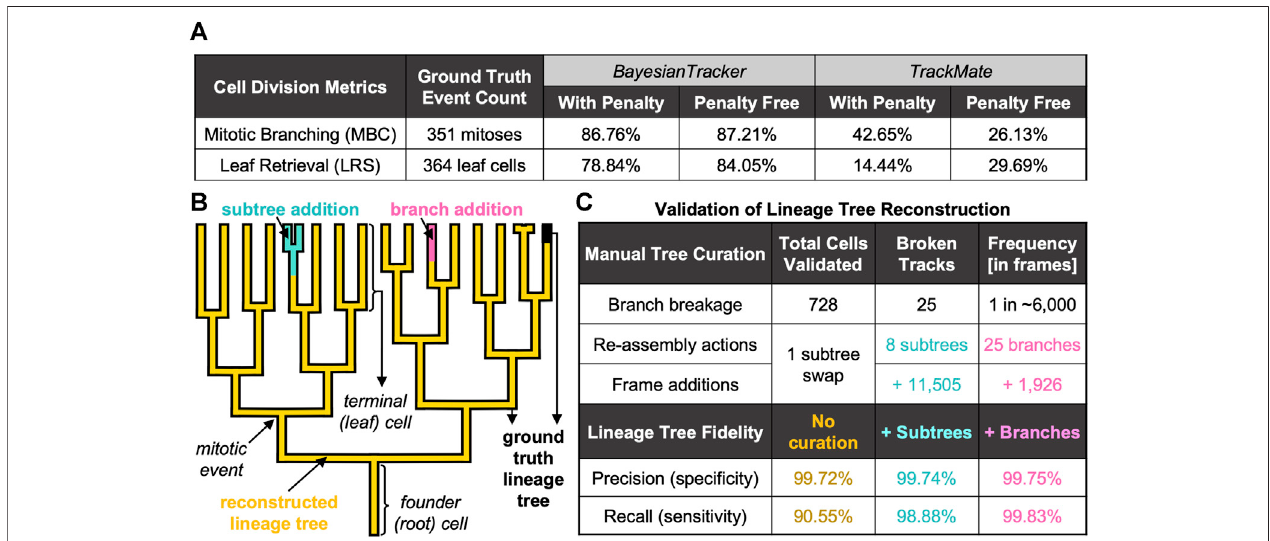
FIGURE 6 | Summary of Benchmarking Metrics to Evaluate the Tracking Performance. (A) Summary of cell division-speci fi c metrics for tracker benchmarking on identical number of ground truth events. (B) Visual overview of automated tree reconstruction with additional manual tree re-assembly. Highlighted are the regions of groundtruthtrees(blackthickbackground)whichwerecorrectlyrecapitulatedby btrack (overlaidgoldenlineage).Uponbranchbreakage,twotypesofassemblyactions were applied: subtree attachment (cyan), where the branch underwent further splitting, or branch attachment (pink), where the track did not further branch. (C) Summaryofadditionalbenchmarkingmetricstoscoretheperformanceof btrack approachwithrespecttosingle-celltrajectoryfollowingandlineagetreereconstruction in naïve btrack outputs and expert annotator re-assembled